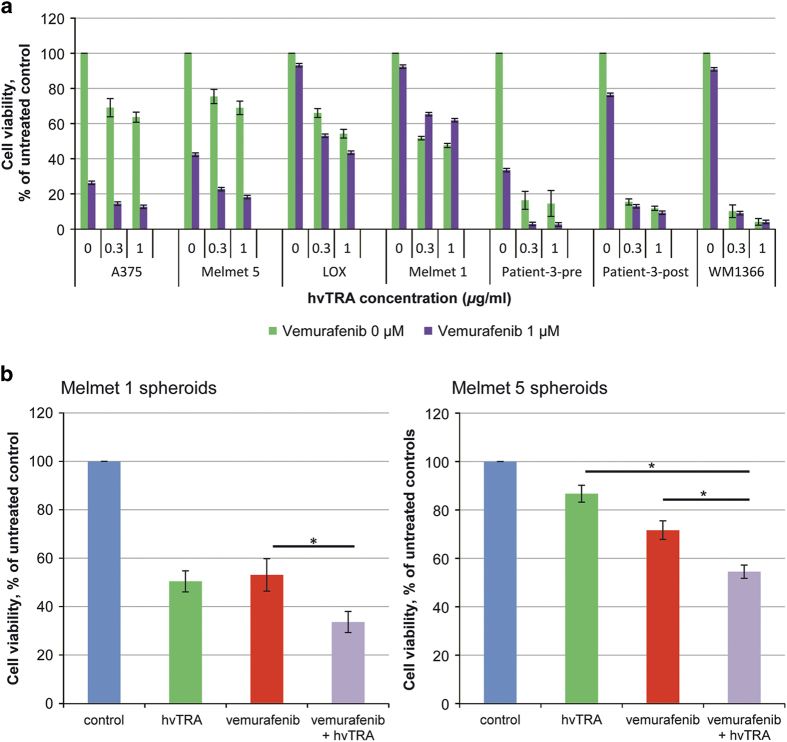
In vitro response to hvTRA, vemurafenib and the combination. (a) Seven melanoma cell lines were exposed to the combination of vemurafenib (1 μM) and hvTRA at selected concentrations (purple bars). The data representing hvTRA mono treatments (green bars) are the same results as shown in Figure 1a. Cell viability was measured after 72 h by MTS assay. The experiments were repeated three times. (b) Melmet 1 and Melmet 5 were grown as spheroids and treated with hvTRA (0.5 μg/ml), vemurafenib (0.3 μM) or the combination. Cell viability was measured using CellTiter-Glo Luminescent assay and measured 96 h after start of treatment. At least four biological replicated were performed, with four technical replicates. The error bars represent±S.E.M. *P<0.05.